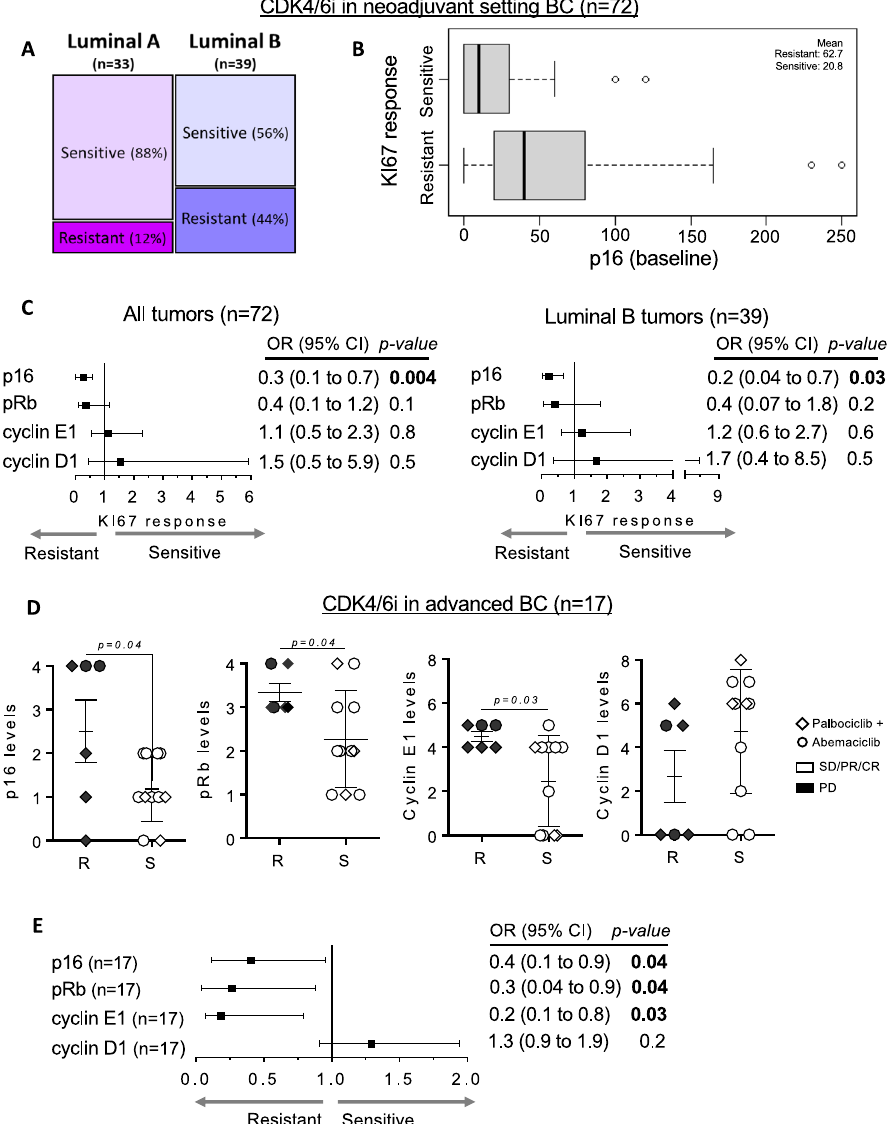
Fig. 5 | High p16 levels associated with lack of response to CDK4/6i in ER + BC patients.A Percentage distribution of sensitivity to abemaciclib after 15 days of treatment in the neoadjuvant setting in the ABC-POP trial ( n =72). Tumors were classi fi ed as Luminal A if %KI67<15 or as Luminal B if %KI67 ≥ 15. Tumors showinglnKI67<1atday15wereconsideredsensitive andthose withln KI67 ≥ 1 were resistant to the studied drug. B Box and whiskers plot showing a logistic model to evaluate the effect of p16 on the response to abemaciclib ( n =39 Luminal B tumors). Box represents the median and the 25th and 75th percen- tiles, whiskers show the largest and smallest value. The mean value of each subgroup is indicated. C Forest plots displaying the odds ratios (OR; black squares) ±95% con fi dence intervals (CI; horizontal lines) of the association between the indicated biomarkers and the percentage of KI67 after treatment